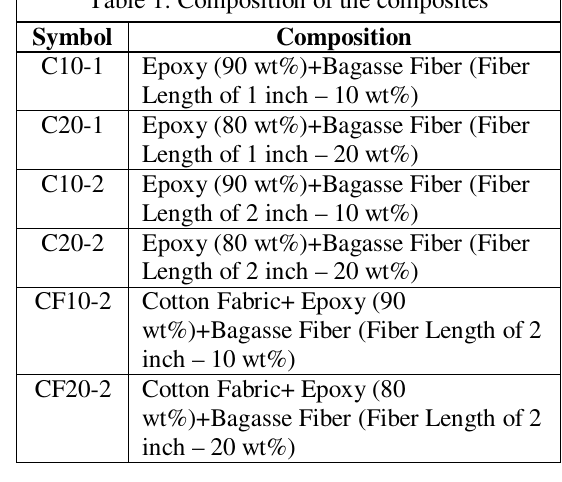
Table 1: Composition of the